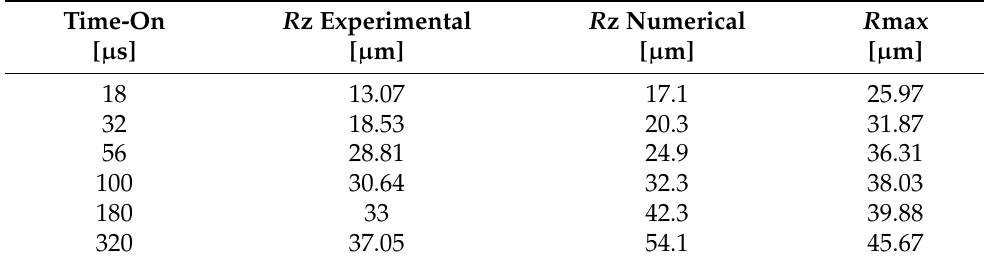
Table 5. Numerical values of the surface roughness as a function of